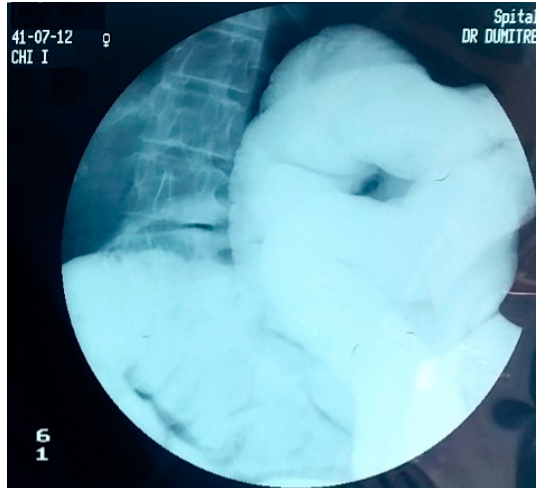
Figure 4. Barium enema. Colon with the deletion of the haustrations at the level of the descendant and the sigmoid.